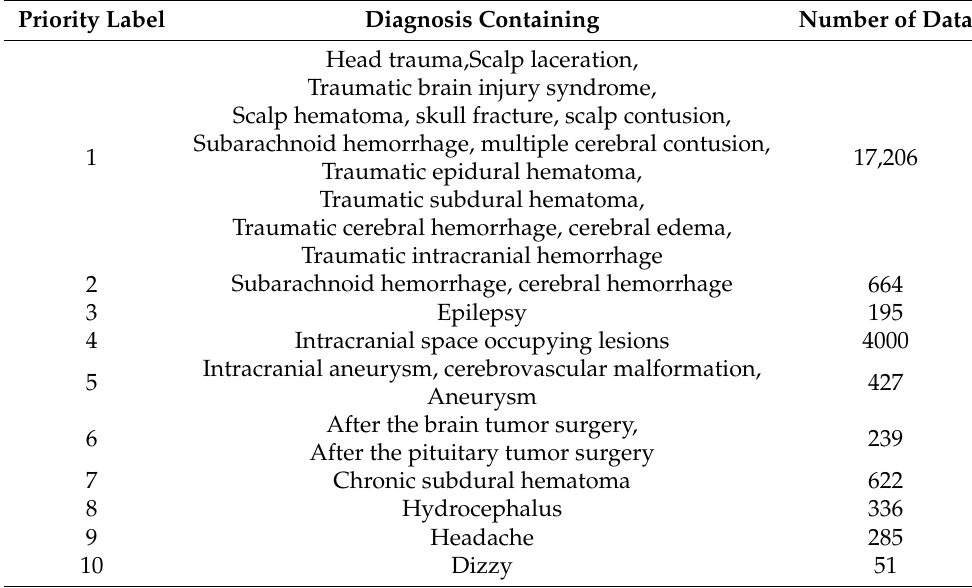
Table 1. Triage priority scheme and number of